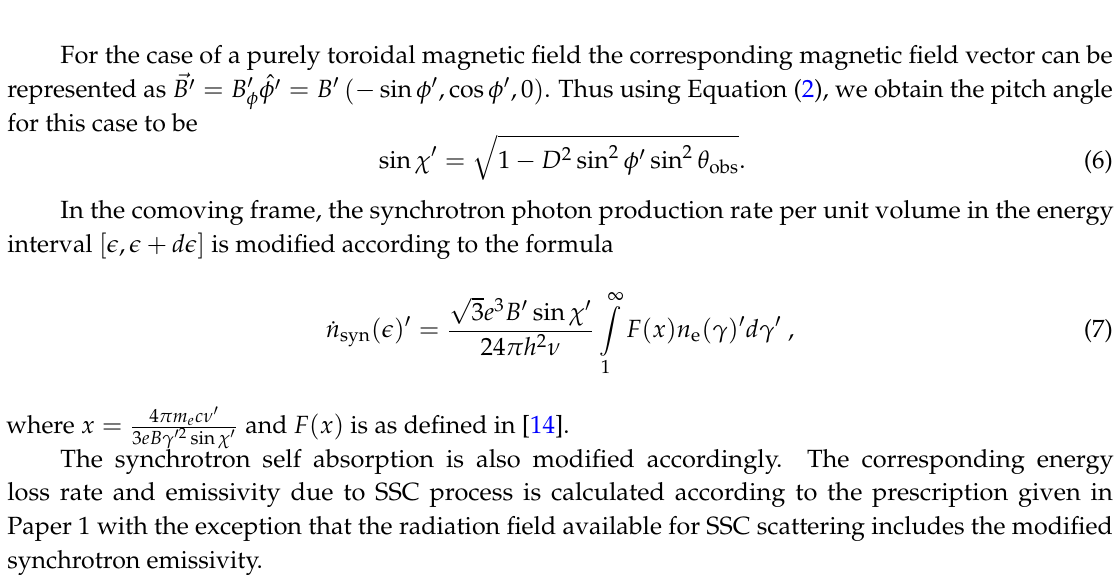
Figure 2. Schematic diagram of the orientation of the magnetic field for an oblique ( left panel ) and purely toroidal ( right panel ) geometry in a single cylindrical zone. All angles and directions shown are in the plasma